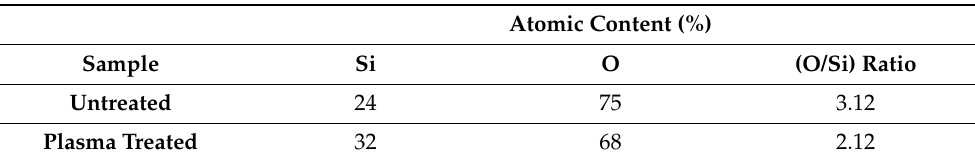
Table 2. Change in atomic concentration of O, Si, and ratio (O/Si) on the surface of untreated and plasma-treated silica